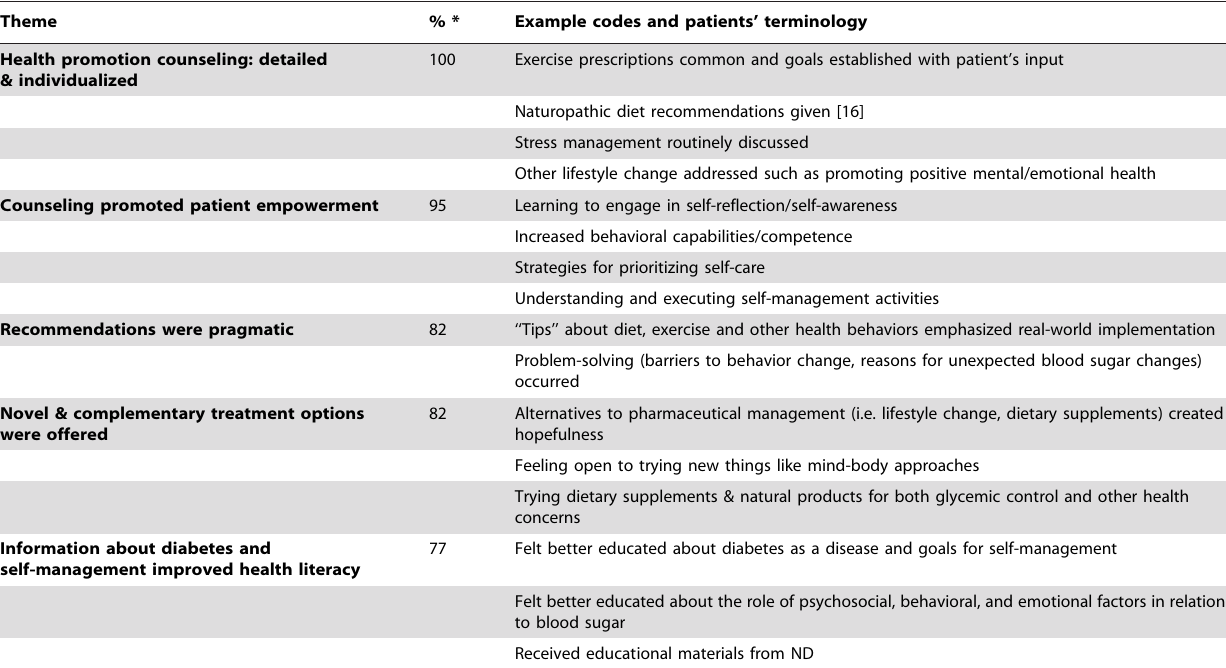
Table 4. Themes related to the content of naturopathic care (n=